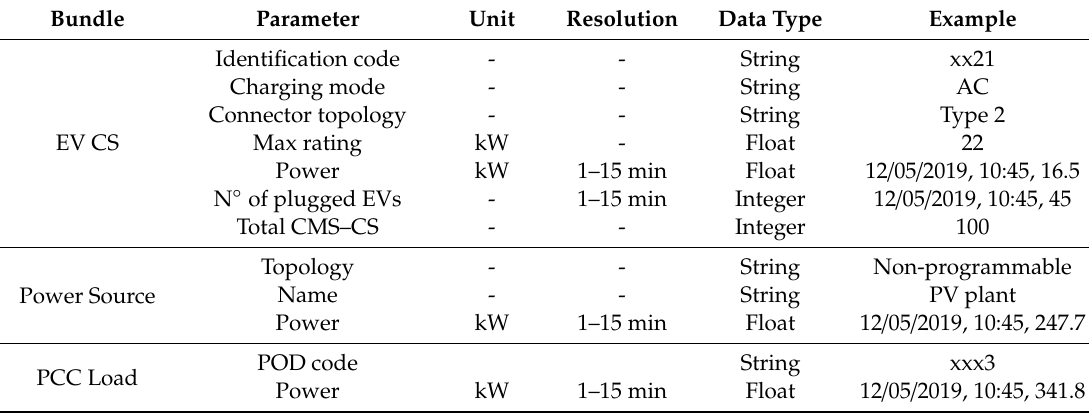
Table 4. The input of the CMS and data